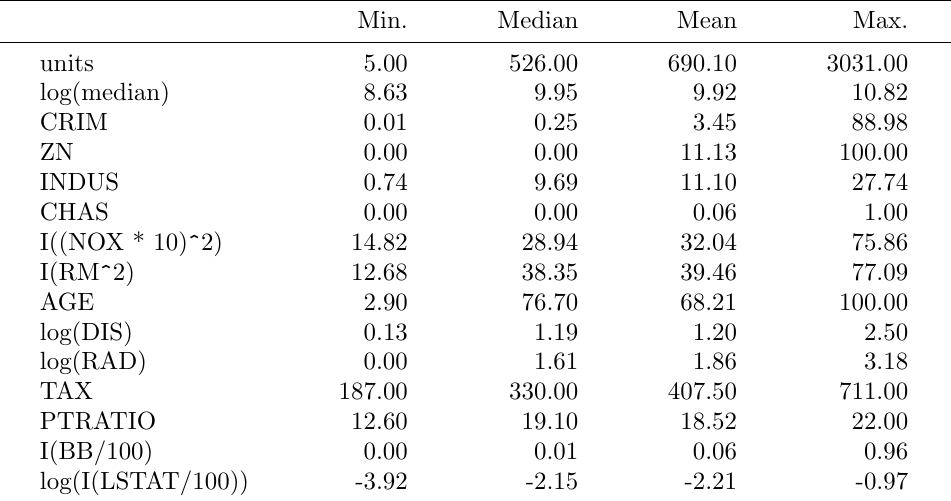
Table A.2: Descriptives for variables included in the hedonic house value regression; 489 non-censored Boston census tracts